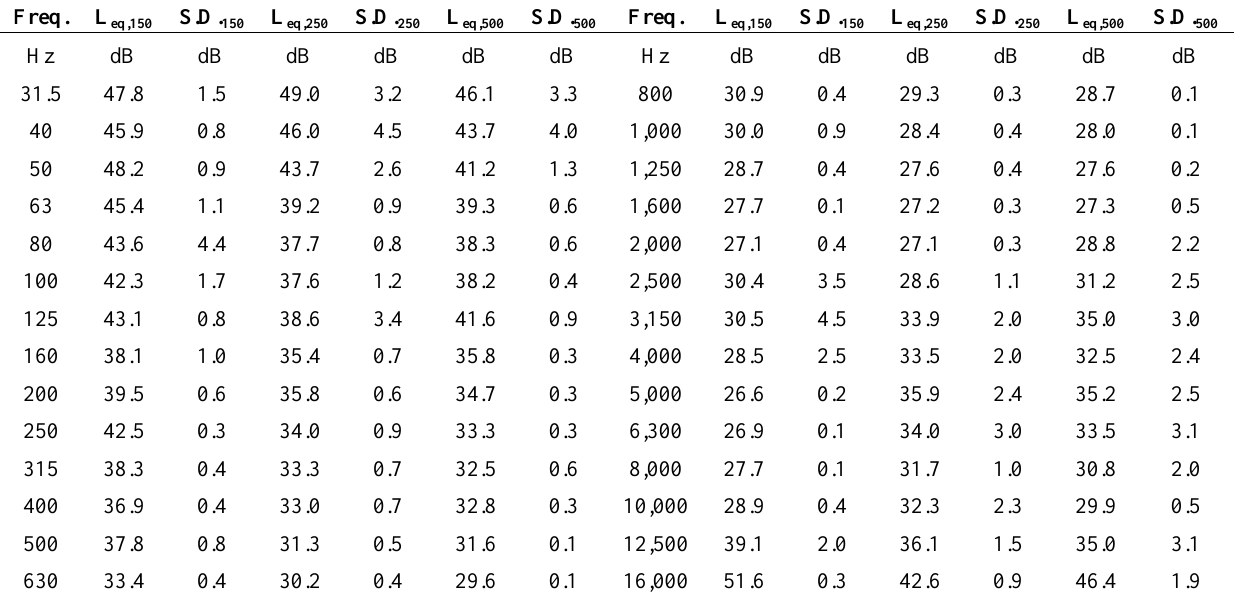
Table 3. Averages and standard deviations one-third octave band Leq at the distance. Freq.